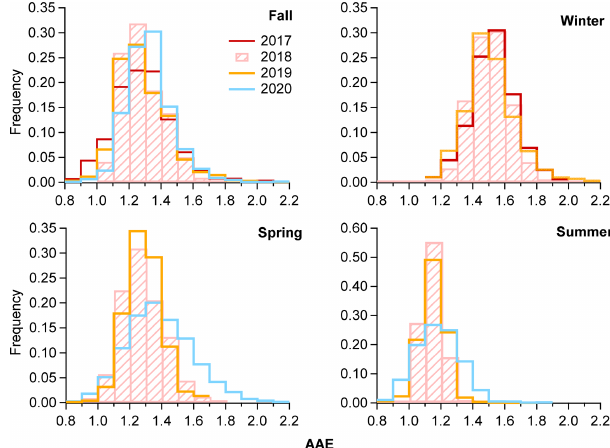
Figure 7. The frequency distributions of AAE in the four